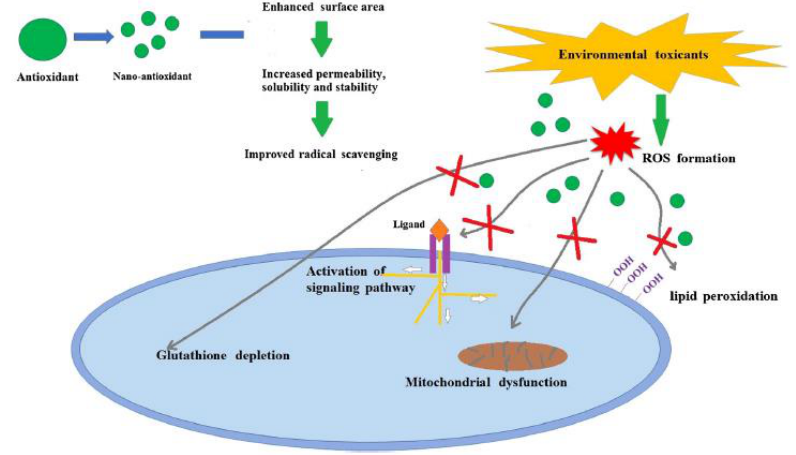
Figure 2. Schematic depiction of oxidative-stress related damage. Nanoantioxidants counterbalance these adverse effects due to their advanced structure. Reprinted (adapted) with permission from [63]. Elsevier.